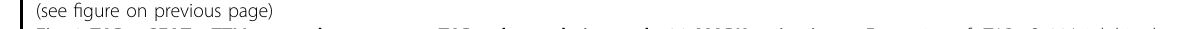
Fig. 3 TAB1 – GFAT1 – TTLL5 complex promotes TAB1 glutamylation and p38 MAPK activation. a Expression of rTAB1-S438A inhibited TAB1 – p38 interaction. A549 cells with depleted TAB1 and reconstituted expression of WT rTAB1 or rTAB1-S438A were cultured for 8 h under glucose deprivation. Immunoprecipitation and immunoblotting analyses were performed using the indicated antibodies. b TAB1 S438A mutation inhibited TAB1 – p38 interaction in vitro. Puri fi ed His-TAB1 WT and His-TAB1-S438A protein with phosphorylation by JNK were mixed with puri fi ed GST-GFAT1 and GST-p38 α . Pull-down and immunoblotting analyses were performed using the indicated antibodies. c , d GFAT1 mediated TAB1 – GFAT1 – TTLL5 complex formation. A549 cells with or without depleted TAB1 ( c ) or GFAT1 ( d ) were cultured for 8 h under glucose deprivation. Immunoprecipitation and immunoblotting analyses were performed using the indicated antibodies. e TTLL5 mediated TAB1 glutamylation. A549 cells transfected with or without TTLL5 siRNA were cultured for 8 h under glucose deprivation. Immunoprecipitation and immunoblotting analyses were performed using the indicated antibodies. f Expression of rTAB1-S438A inhibited TAB1 glutamylation. A549 cells with depleted TAB1 and reconstituted expression of WT rTAB1 or rTAB1-S438A were cultured for 8 h under glucose deprivation. Immunoprecipitation and immunoblotting analyses were performed using the indicated antibodies. g Expression of rTAB1-S438A inhibited TAB1 glutamylation in vitro. A549 cells with depleted TAB1 and reconstituted expression of WT rTAB1, rTAB1-S438A or rTAB1-S438D were cultured for 8 h under glucose deprivation with CoCl 2 (10 μ M). Immunoprecipitation, in vitro polyglutamylase assay and immunoblotting analyses were performed using the indicated antibodies. h TAB1 E212 was glutamylated.